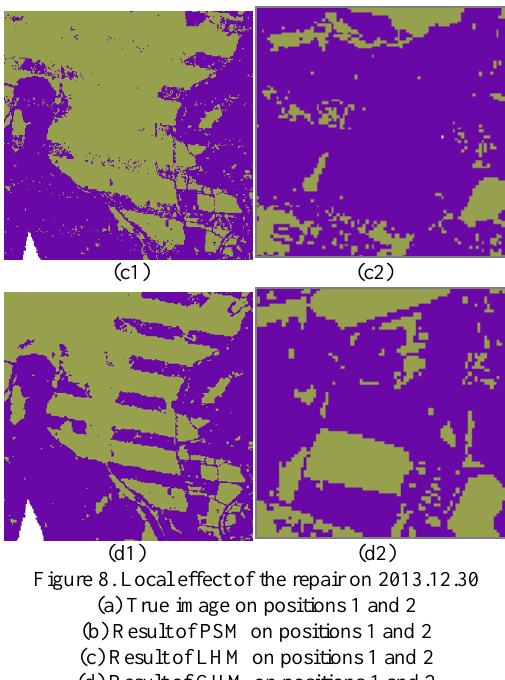
Figure 8. Local effect of the repair on 2013.12.30